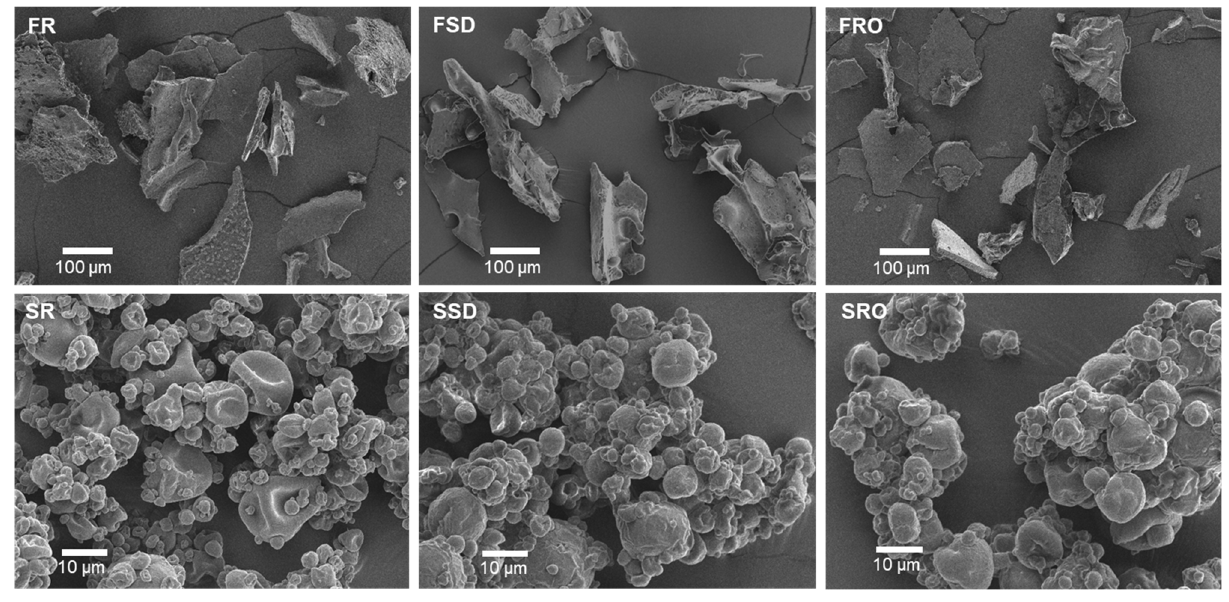
Figure 2. Scanning electron microscopy (SEM) images of camel milk powders. FR, freeze-dried raw milk powder; FSD, spray-dewatering-concentrated/freeze-dried milk powder; FRO, reverse-osmosis-concentrated/freeze-dried milk powder; SR, spray-dried raw milk powder; SSD, spray-dewatering-concentrated/spray-dried milk powder; SRO, reverse-osmosis-concentrated/spray-dried milk powder.